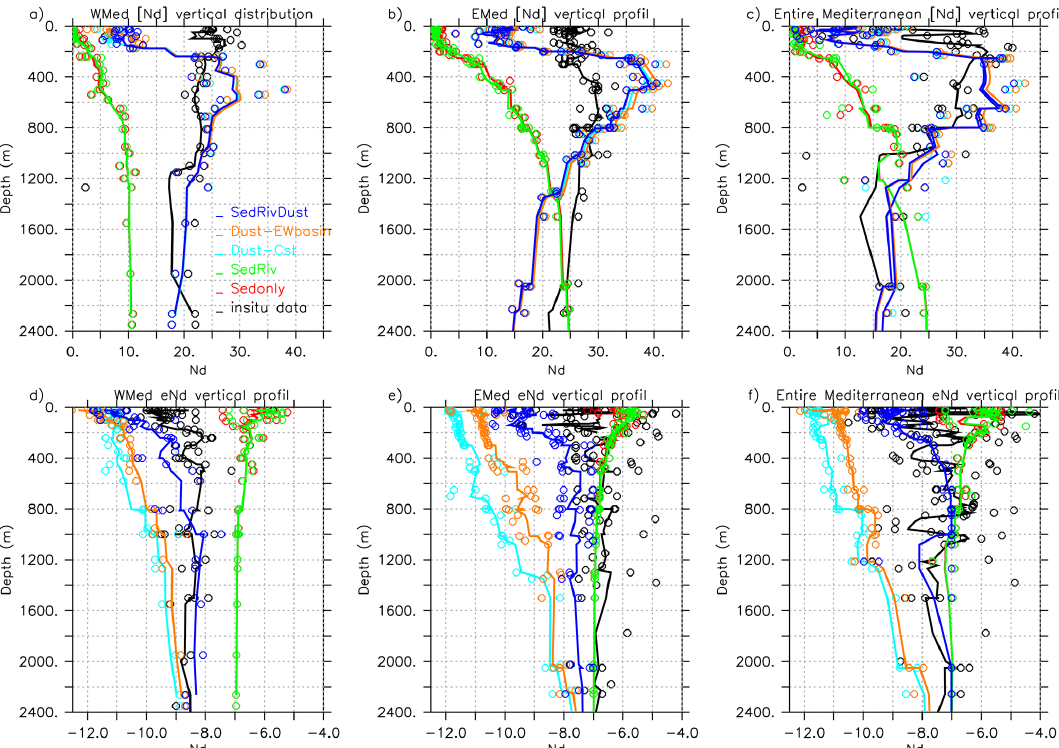
Figure 5. Upper panel is the comparison of average vertical profiles of [Nd] (in pmolkg − 1 ) in the western basin (a) , eastern basin (b) , and whole Mediterranean Sea (c) , presenting model results against in situ data from (Tachikawa et al., 2004; Vance et al., 2004; Henry et al., 1994; Dubois-Dauphin et al., 2017; Garcia-Solsona and Jeandel, 2020; Montagna et al., 2022). Lower panel is the same as in upper panel for ε Nd (in ε